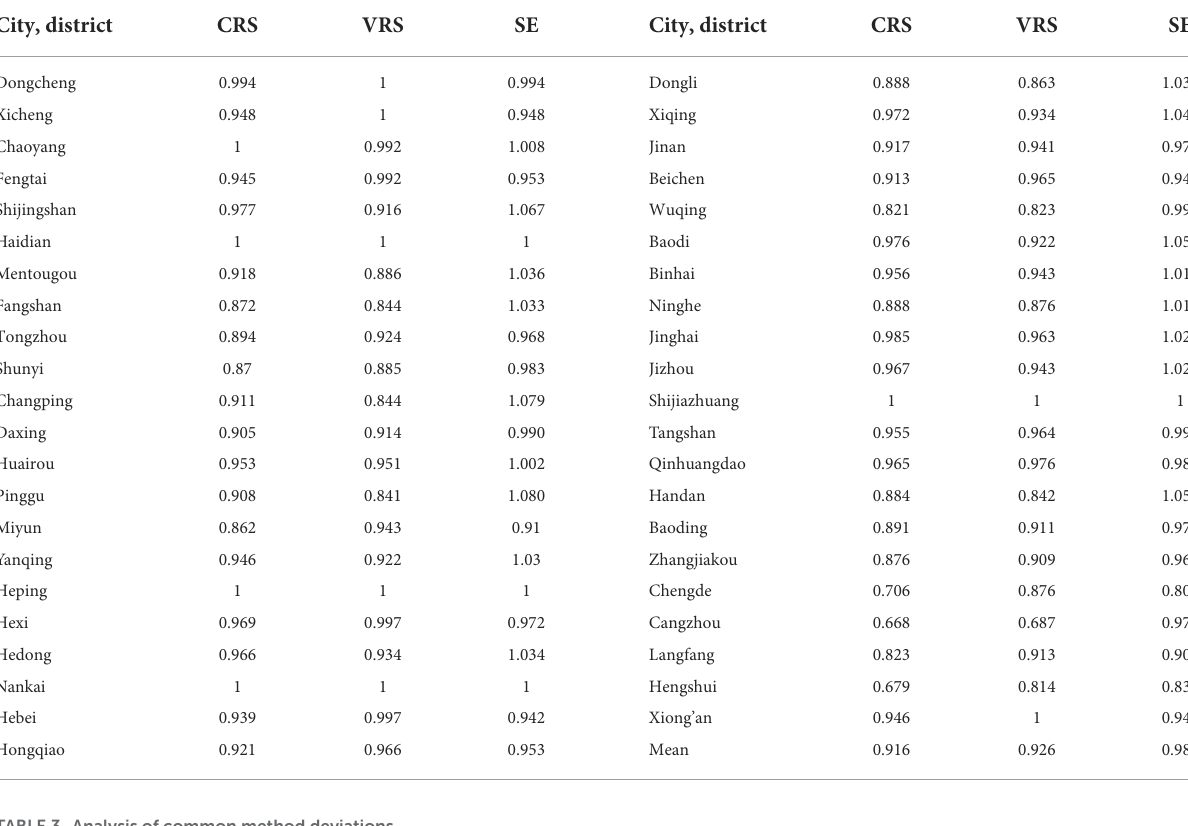
TABLE 2 Efficiency of food safety supervision in cities and districts in Beijing-Tianjin-Hebei. City, district